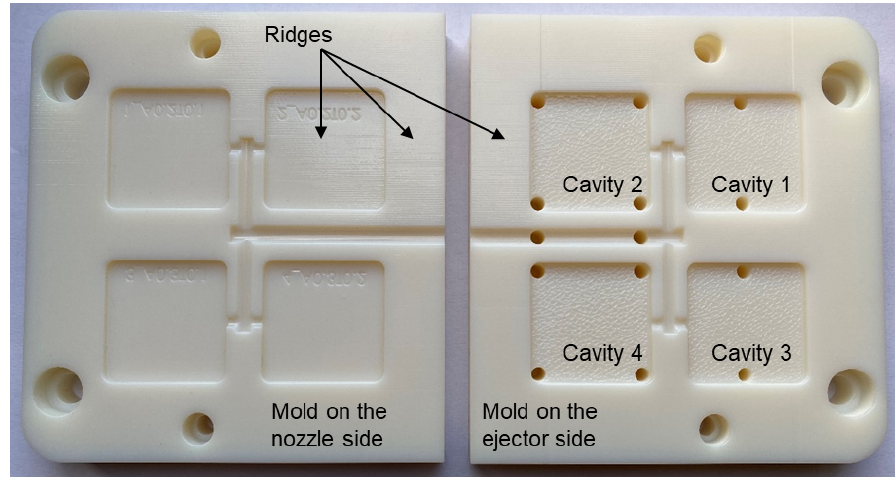
Figure 2. Mold with grain structure produced by means of